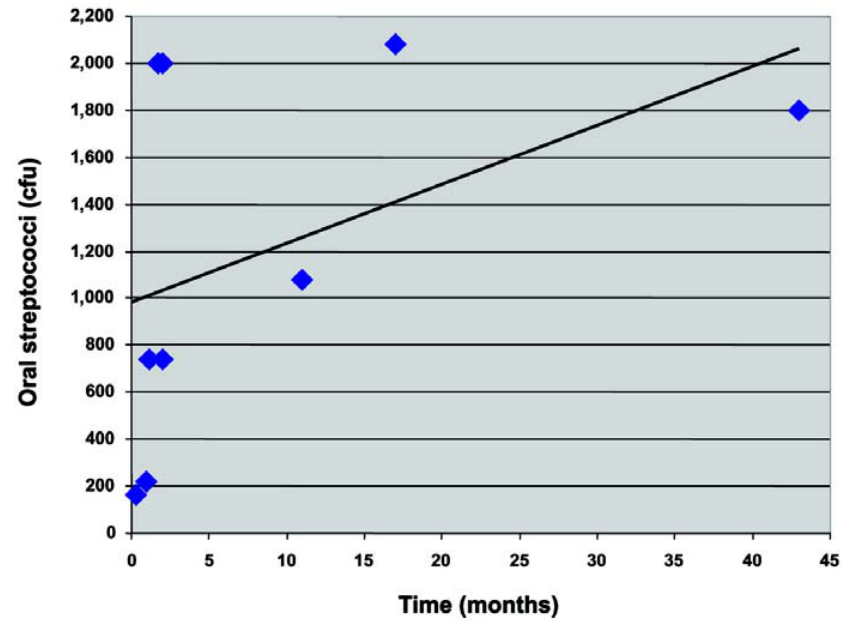
FIGURE 1- Graph demonstrating the correlation between the number of colony forming units (cfu) of oral streptococci and the time elapsed from dental trauma until endodontic treatment